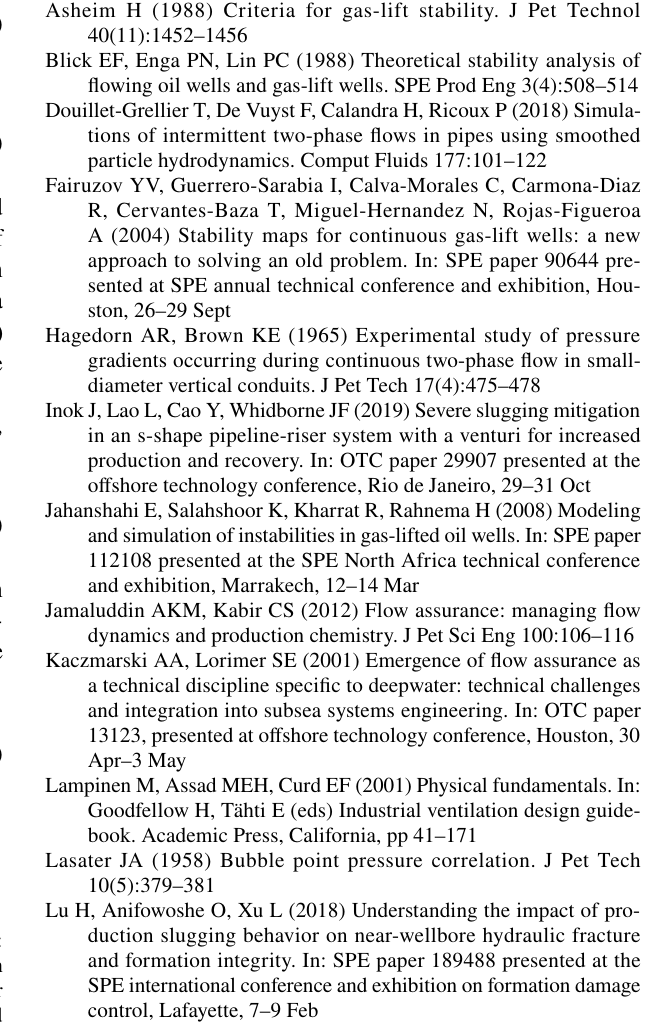
y y x y = f ( x ) and x = g ( y ) curves, o , o ) and ( o , o ) on